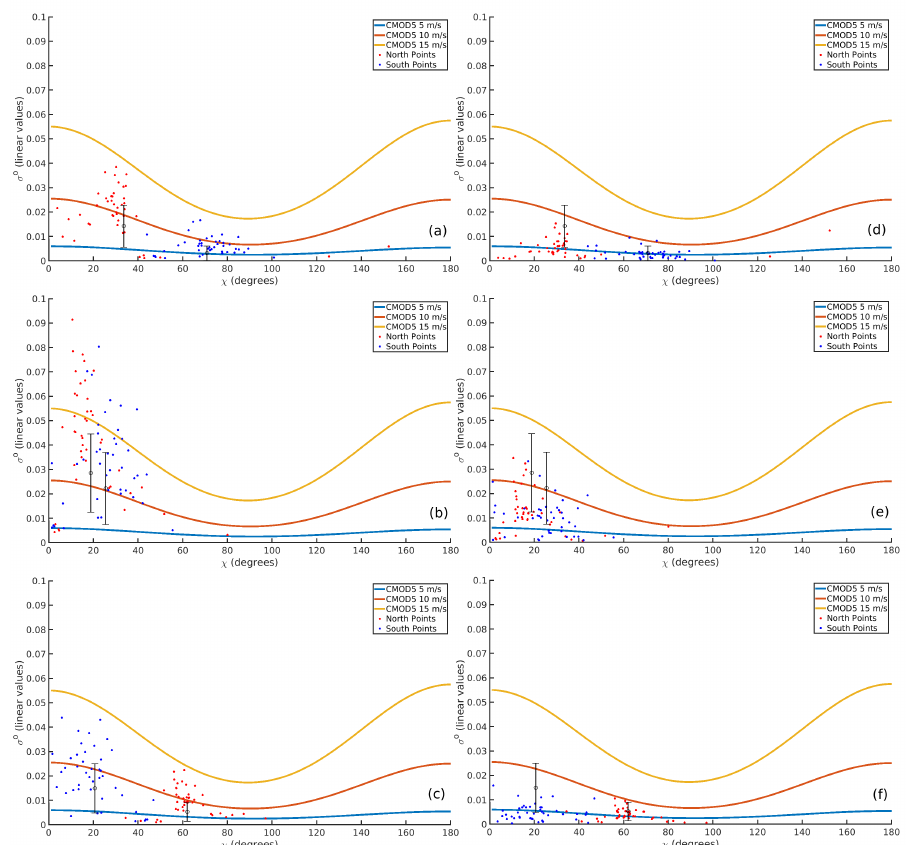
Figure 5. ASCAT σ 0 from multiple revs from a point (see Figure 8 a) in the north high wind speed region and a point in the south high wind speed region are plotted for fore ( a ), mid ( b ), and aft ( c ) looks. Corresponding NWP predicted σ 0 are shown in ( d–f ) for the same beams. σ 0 curves at 50 ◦ incidence angle for CMOD5 for 5, 10, and 15 m/s are plotted in each panel for reference. Error bars showing the average difference between ASCAT measured σ 0 and NWP predicted σ 0 and the standard deviation of the differences are plotted in